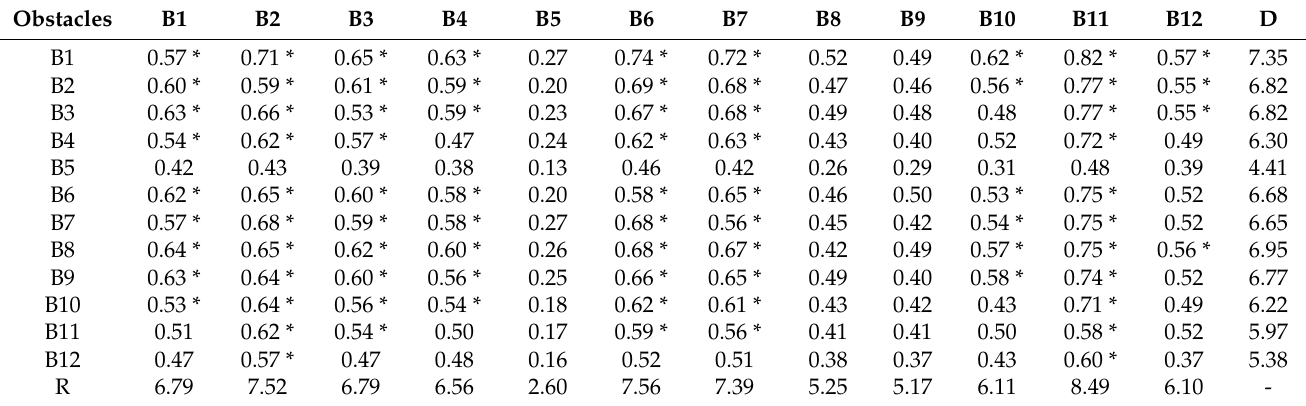
Table 13. Calculate the total-relation matrix (T).